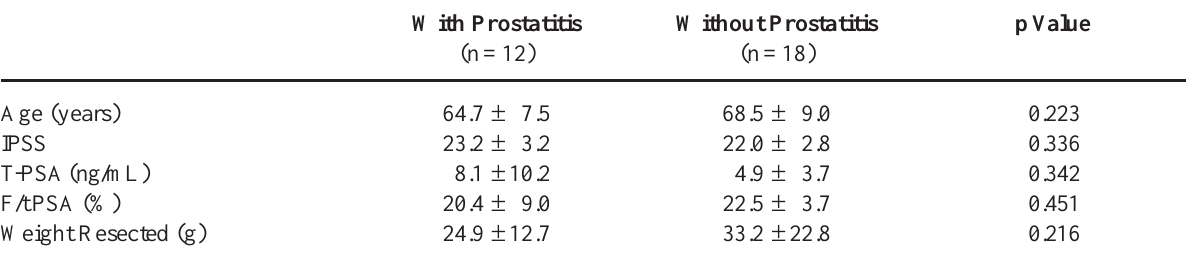
Table 2 – Baseline data, according to the presence of prostatitis .